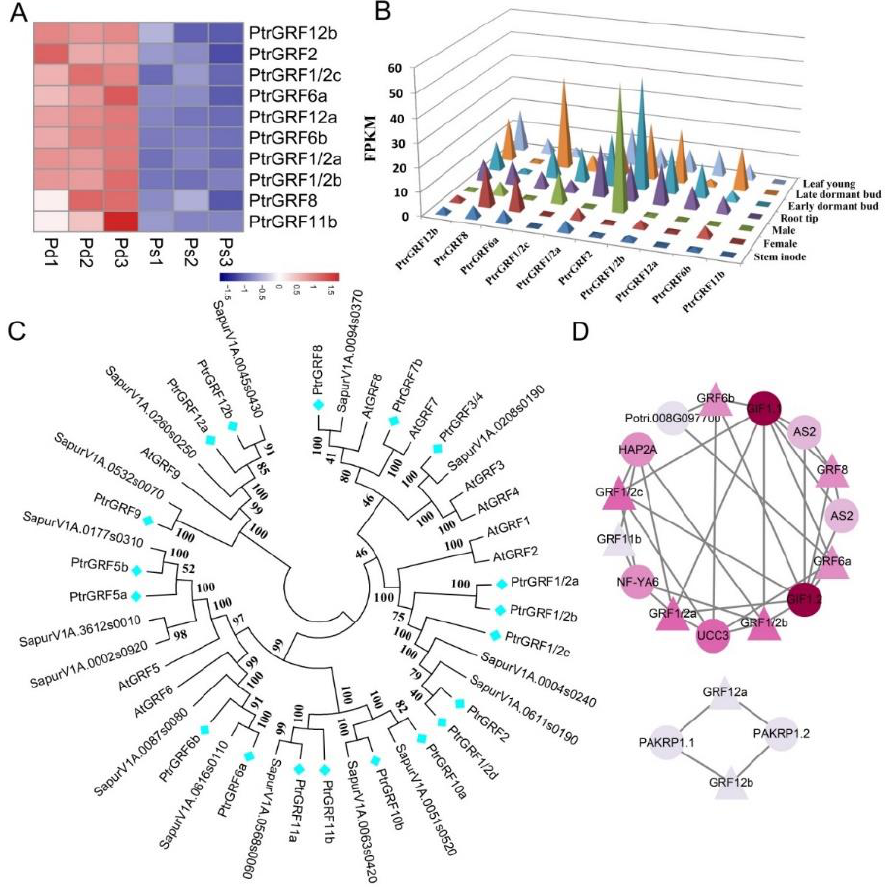
Figure 4. Phylogenetic analysis and expression patterns of the PtrGRF family. ( A ) The DEGs of the PtrGRF family in Pd and Ps. ( B ) Expression patterns of PtrGRFs across various tissues. ( C ) Phylogenetic analysis. The phylogenetic tree was constructed using the full-length amino acid sequences by the neighbor-joining (NJ) method with 1000 bootstrap replicates. ( D ) Protein–protein interaction (PPI) network of differentially expressed GRFs . The color from light to dark represents the degree of connection.